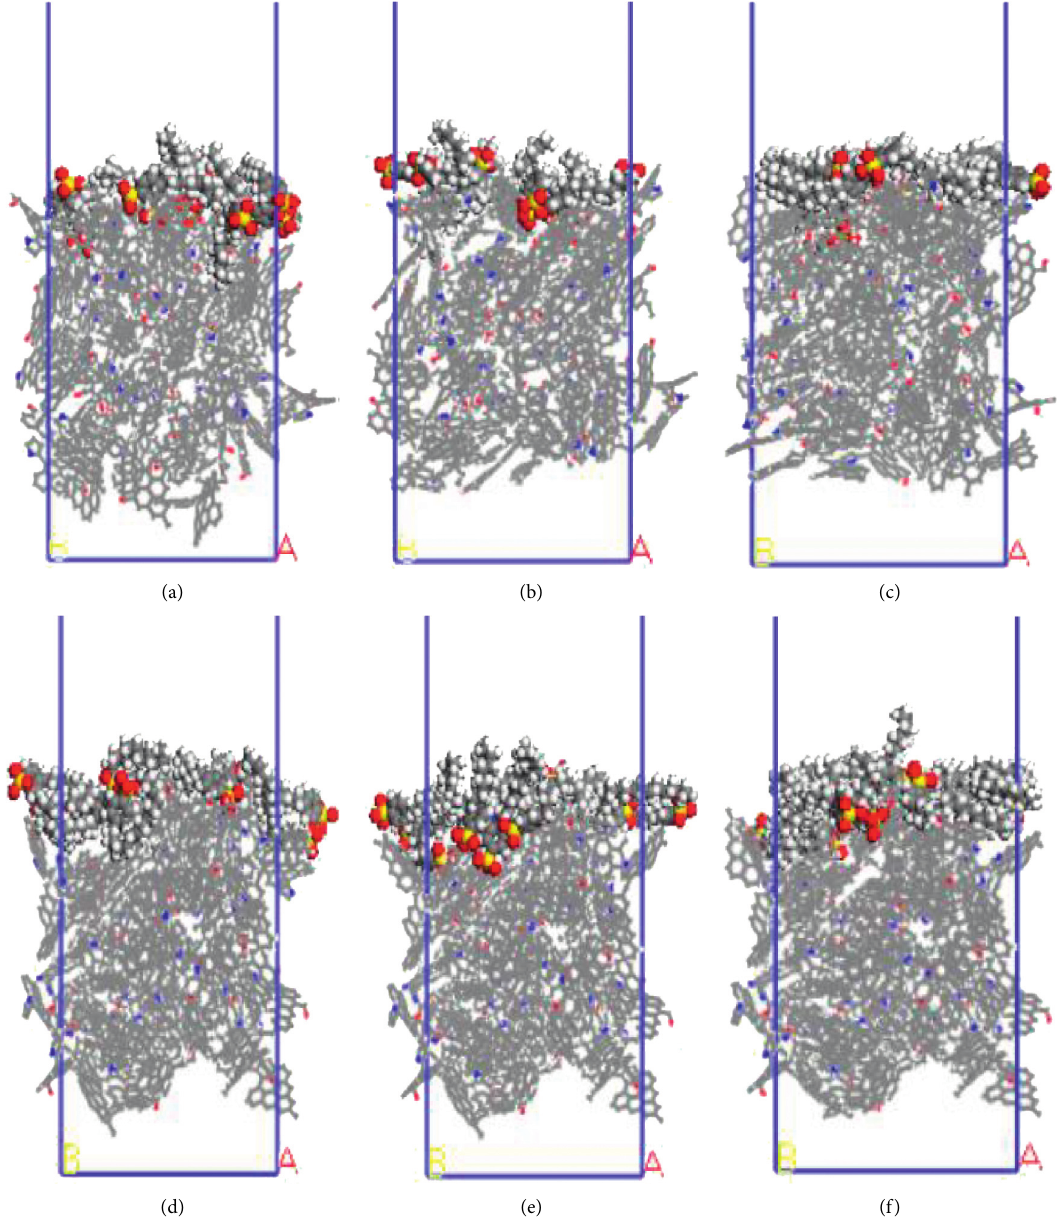
Figure 3: Equilibrium configuration of surfactant-anthracite system after MD simulation. (a) C8; (b) C10; (c) C12; (d) C14; (e) C16; (f) C18 (the yellow balls represent the sulfur atoms).